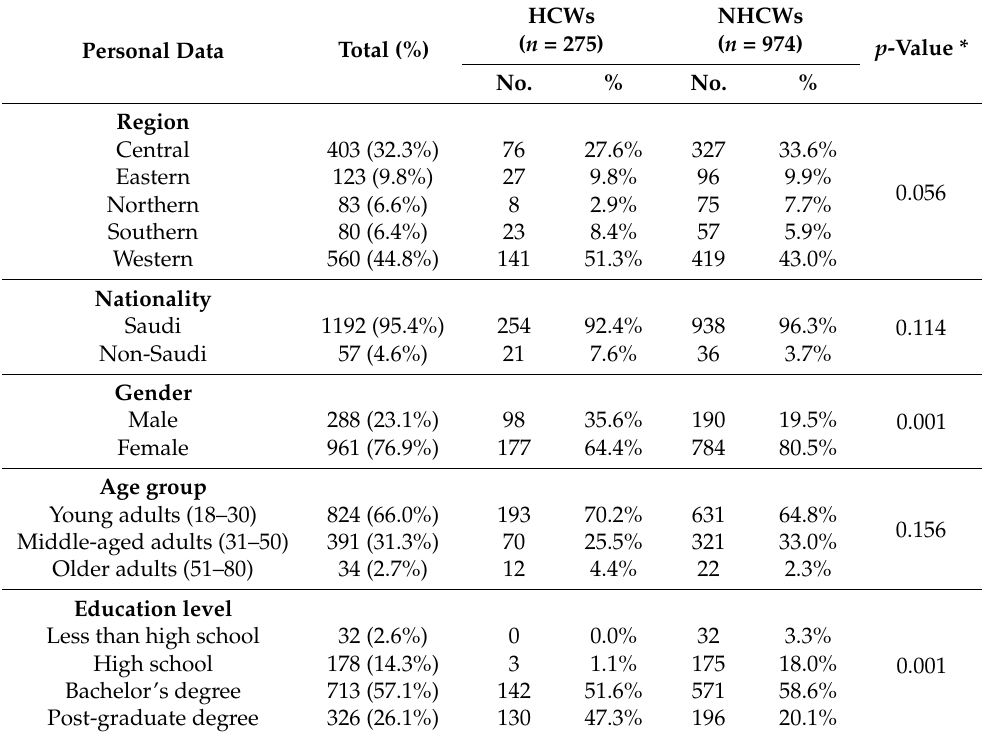
Table 1. Distribution of study groups according to their personal characteristics. N = 1249; HCWs, healthcare workers; NHCWs, non-healthcare